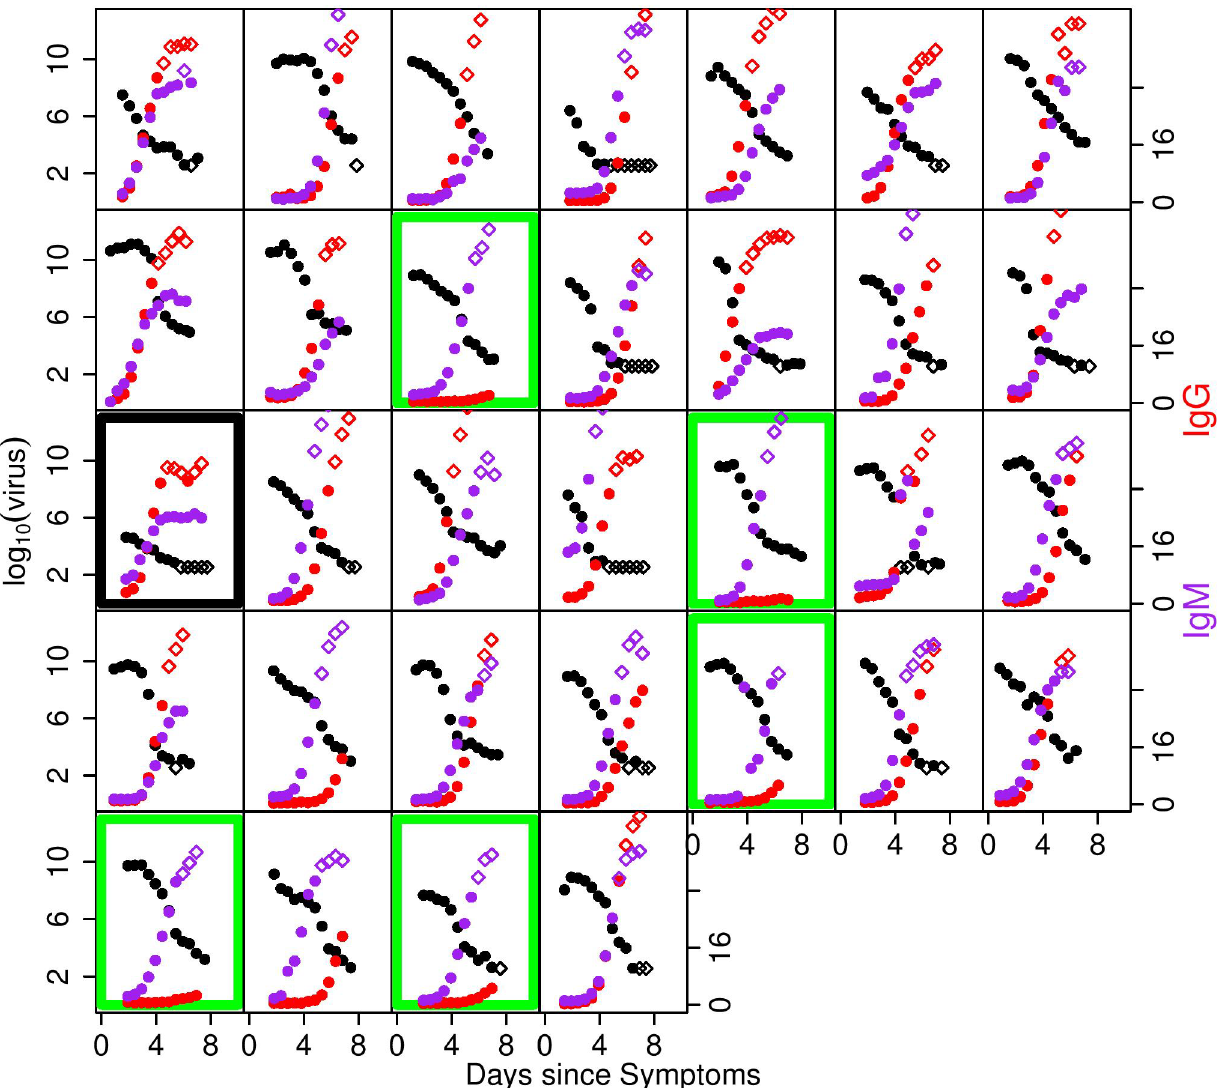
Fig 1. Measured RNA and antibody titres over time for DENV1-infected subjects. The left hand axis shows log 10 RNA copies/ml of plasma in black. The right hand axis shows IgG titres in red and IgM titres in purple (both on a linear scale). Each box represents the viral and antibody measurements of a different individual. Unfilled marker symbols show measurements below the assay limit of detection for virus and above the upper limit of reliable (linear) quantification for IgG and IgM [13]. Subjects classified as primary infections are outlined in green. Patient 15, who shows the lowest RNA titres overall, is outlined in